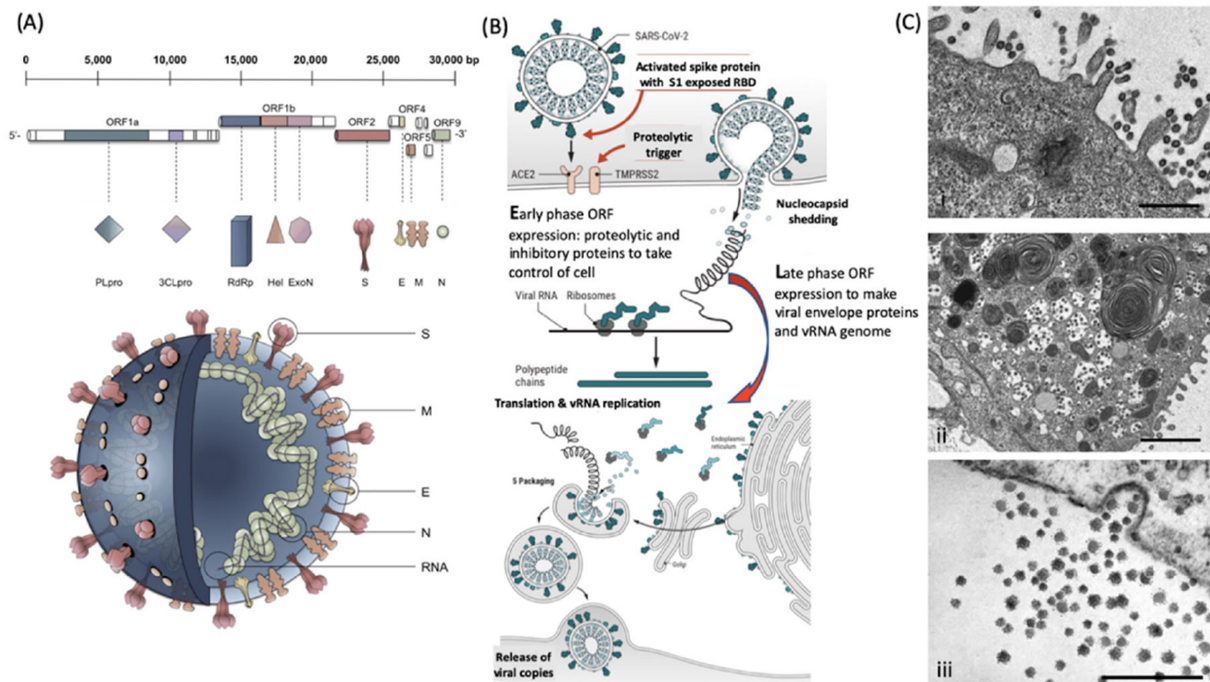
Figure 2. Molecular cellular pathology of SARS-CoV-2 infection. Panel ( A ). Schematic illustration of SARS-CoV-2 viral RNA genome in relation to order of expression and functional incorporation with the virion particle. The genome comprises a 5 ′ -untranslated region (5 ′ -UTR), open-reading frames (ORFs) 1a and 1b encoding nonstructural proteins 3-chymotrypsin-like protease (3CLpro), papain-like protease (PLpro), helicase (Hel), and RNA-dependent RNA polymerase (RdRp) as well as accessory proteins, and the structural S protein (S), E protein (E), M protein (M), and Nucleocapsid protein (N) in ORFs 2, 4, 5 and 9. Panel ( B ). Schematic of virion fusion mediated by Spike protein attachment to the ACE2 receptor and accessory cleavage of the Spike protein quaternary complex, resulting in fusion peptide exposure and binding to target cell plasma membrane. Focal, host cell and viral envelope lipid bilayer membrane fusion and viral RNA ingress of the target host cell. Shedding of nucleocapsid and early ORF expression to take control of the cell and inactivate internal anti-viral proteins (e.g., Ubiquitin and RNase). Late ORF expression: replication of viral RNA genome and expression of, via post-translational processing mechanisms of the endoplasmic reticulum and Golgi apparatus (e.g., glycosylation), membrane embedded proteins that are responsible for infectivity including the Spike protein complex. Copies of SARS-CoV-2 vRNA are packaged into lipid bilayer membrane envelopes containing multiple copies of S, E, M and N, glyco- and phospho-proteins. Inclusion transport vesicle, packed with enveloped virions, fuses with host cell membrane releasing infective SARS-CoV-2 virion. Panel ( C ). Electro-micrographs of multiple virions attacking the cell membrane ( i ), viral genome expression subsuming all functions of the cell to form thousands of virion copies within inclusion vesicles ( ii ) and finally release of multiple virions by fusion of inclusion packaging vesicles with the cell surface plasma membrane of the infected host cell ( iii ) [15]. Original composite figure adapted in parts from Depfenhart et al. [16] Kupferschmidt and Cohen [17] and Mason [18]. Scale bar: 1000 nm.